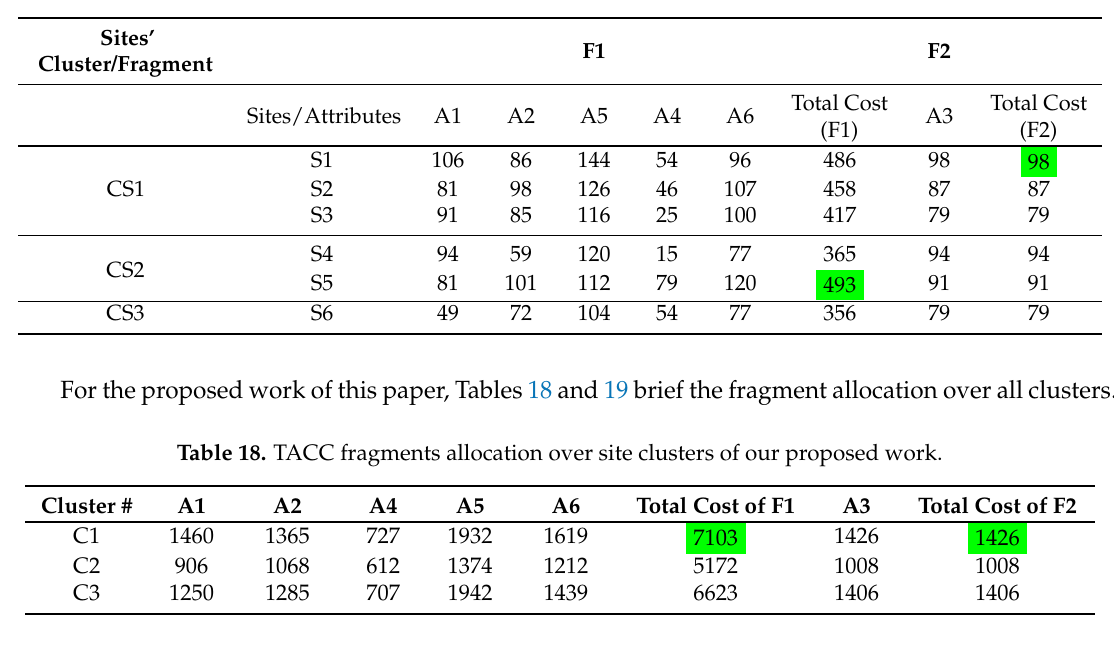
Table 17. Fragment allocation over sites (Scenario 2), [7].